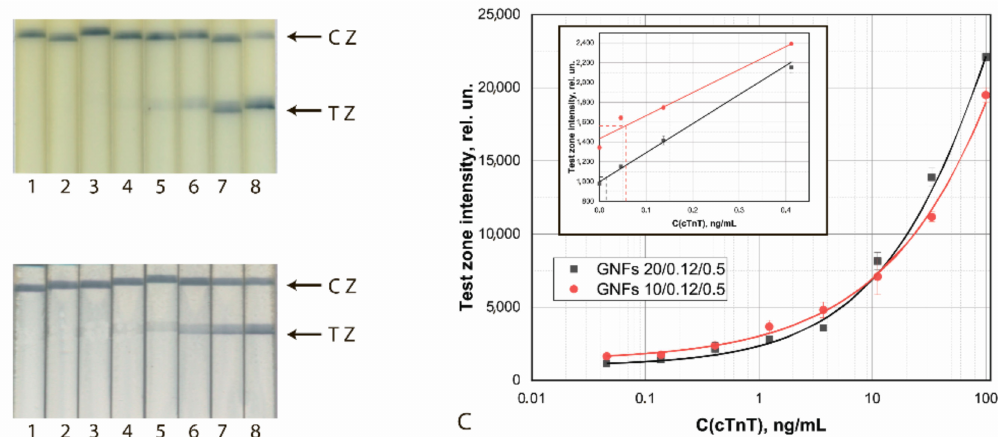
Figure 11. Detection of cTnT in buffer by LFIA using the conjugates GNFs (10/0.12/0.5)–Ab4/cTnT ( A ) and GNFs (20/0.12/0.2)–Ab2/cTnT ( B ). ( A , B ) Appearance of test strips after analysis of samples containing 0 (1), 0.12 (2), 0.4 (3), 1.2 (4), 3.7 (5), 11.1 (6), 33 (7), and 100 (8) ng/mL of cTnT. ( C ) Dependences of the coloration intensity of the TZs on the concentration of